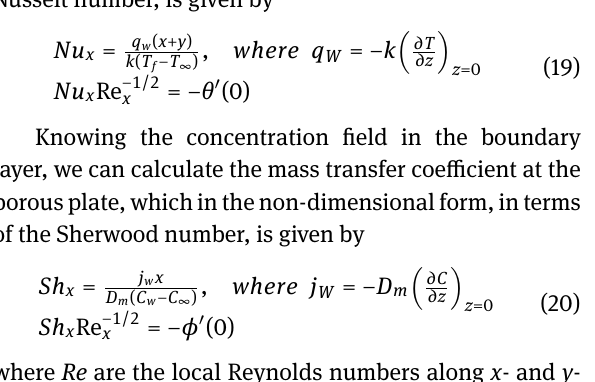
Fig. 3: Influence of β on g (cid:48) ( η )